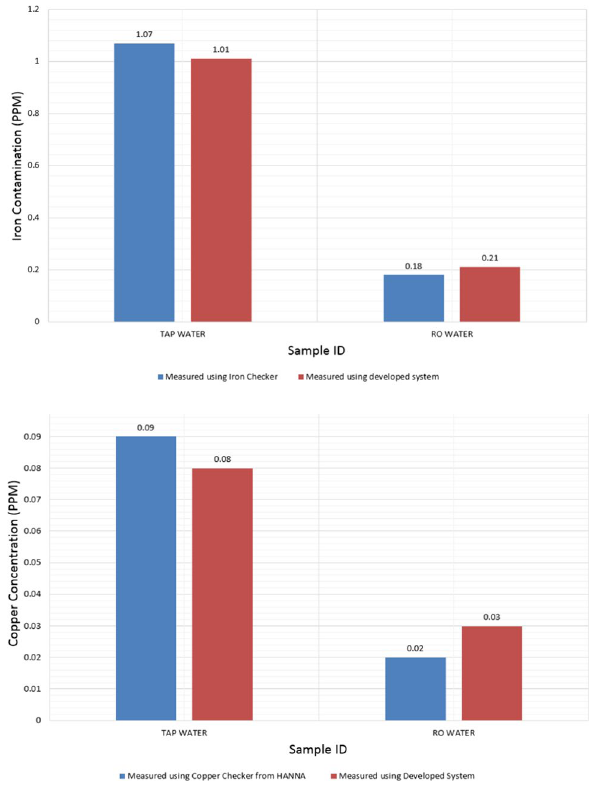
Fig. 10 Validation of developed spectrometer system with commer- cially imported system for unknown concentrations of copper and iron